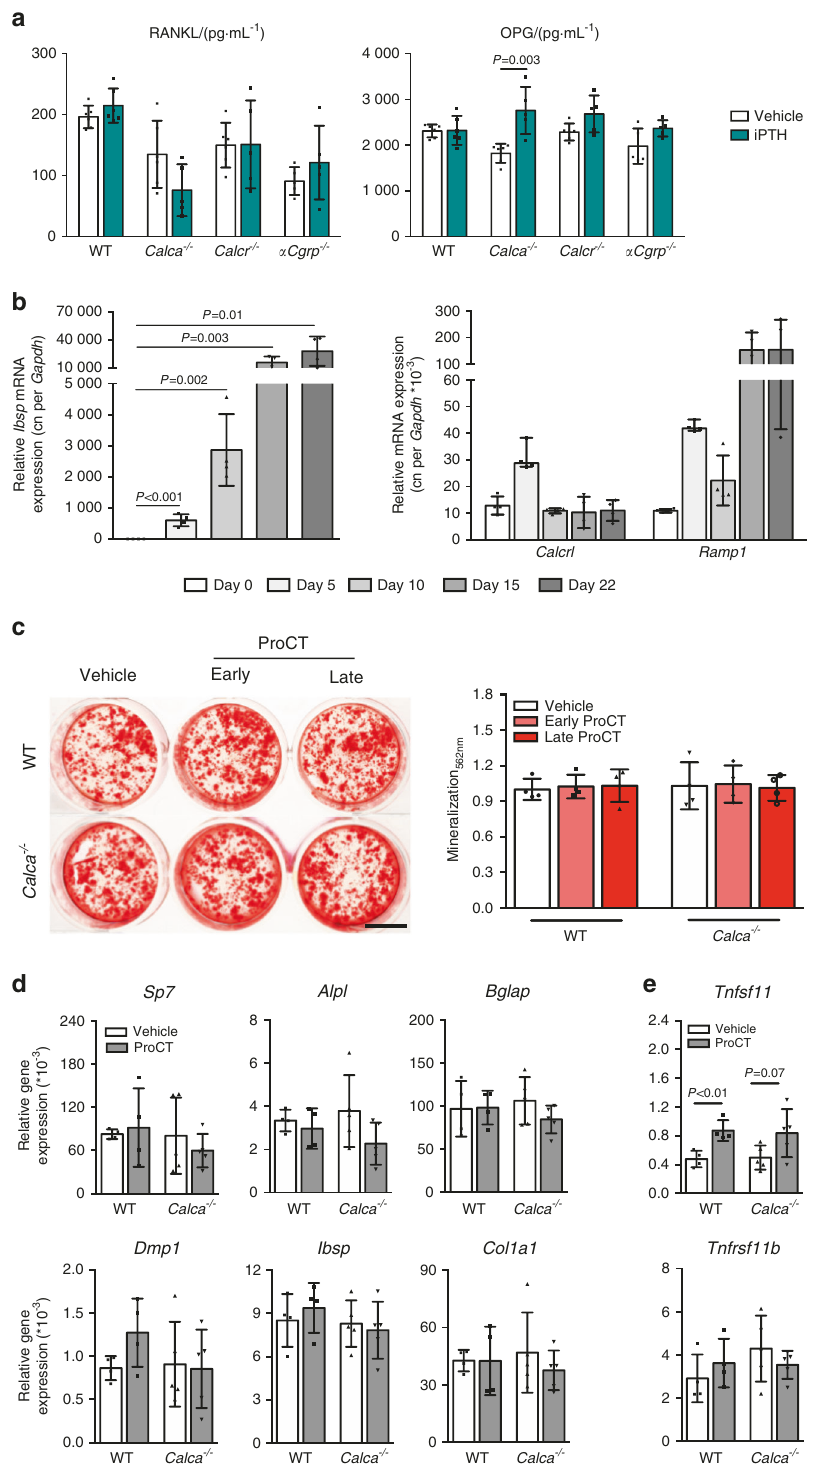
Fig. 5 ProCT does not affect osteoblast differentiation or function. a Serum levels of proresorptive RANKL and antiresorptive OPG in mice of the indicated genotypes treated with iPTH (100 μ g·kg − 1 ) or vehicle for 4 weeks. n = 5 – 6 mice per group. b Gene expression levels (virtual copy numbers) of the osteoblast marker Ibsp as a control (left) and the indicated CGRP receptor components ( Calcrl and Ramp1 ) in calvaria-derived osteoblasts during the course of differentiation. n = 4 independent cultures per group. c Alizarin red staining of calvaria-derived osteoblasts (WT and Calca − / − ) continuously stimulated with ProCT beginning on Day 0 (ProCT early) or Day 5 (ProCT late) of osteoblast differentiation (scale bar = 4 mm). The quanti fi cation of extracellular matrix mineralization is displayed on the right. n = 4 independent cultures per group. In ( a – c ), one-way ANOVA followed by Tukey ’ s post hoc test was applied. d Relative gene expression levels (fold differences) of the indicated osteoblast markers and ( e ) osteoblast-derived regulators of bone resorption in WT and Calca -de fi cient osteoblasts on Day 10 of differentiation. Tnfsf11 = RANKL; Tnfrsf11b = OPG. n = 4-5 independent cultures per group (unpaired Student ’ s t